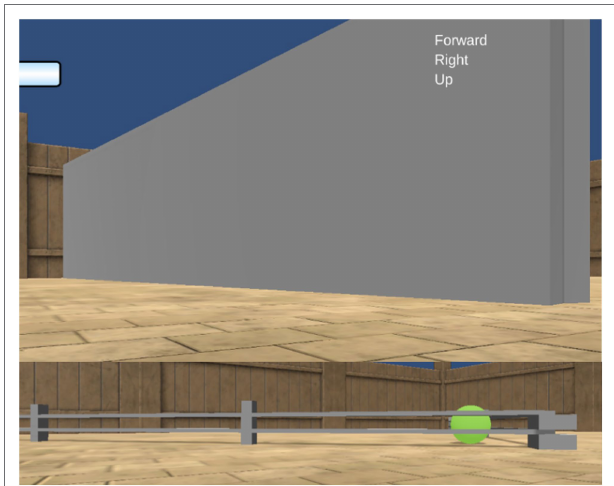
FIGURE 8 | Different static obstacles in the AAI Testbed. Cuboidal blocks in L1-L5 (Top). Fence-like structures in L6 (bottom). Images of the Animal-AI Environment and Testbed are licensed under Apache License, Version 2.0 (http://www.apache.org/licenses/LICENSE-2.0)